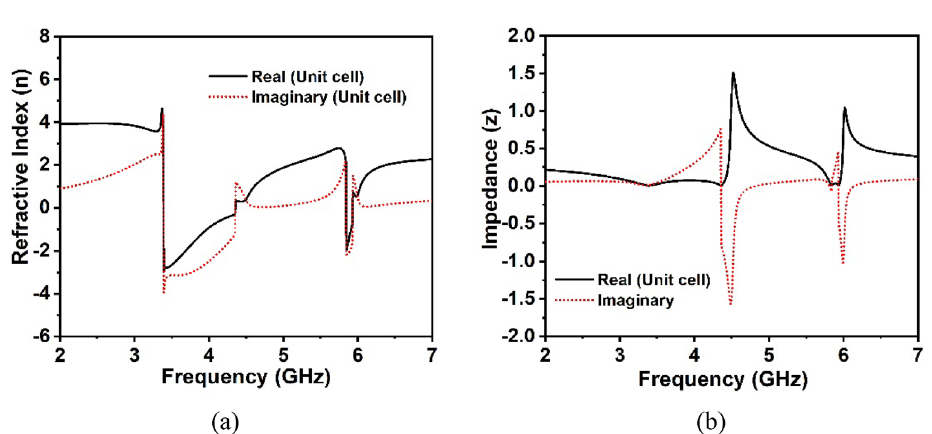
Figure 6. ( a ) Refractive index and ( b ) input impedance (CST post-processing approach) of the proposed unit cell at operating bands.